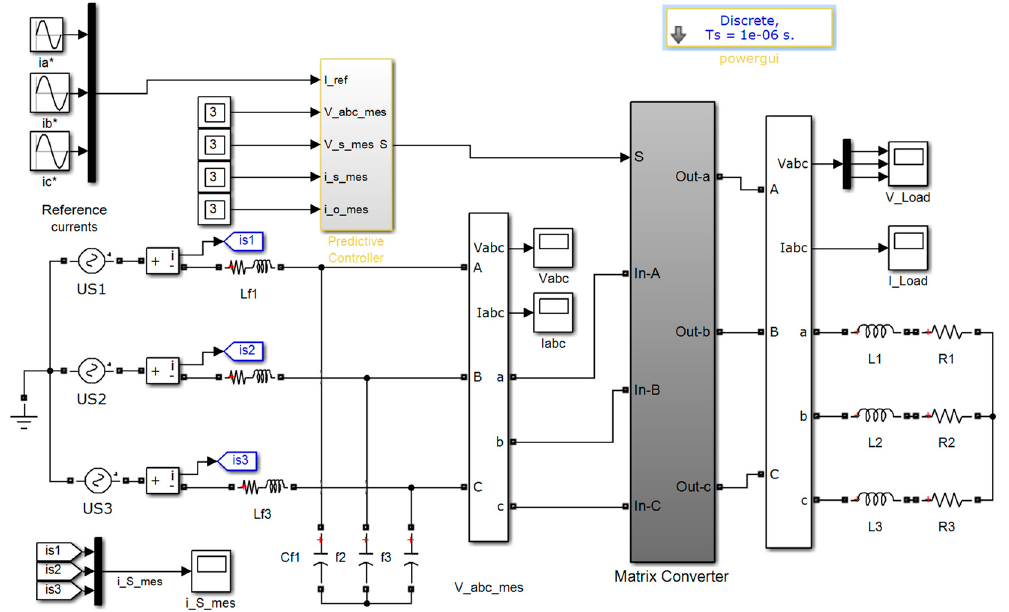
Figure 2. Matrix converter simulation diagram.